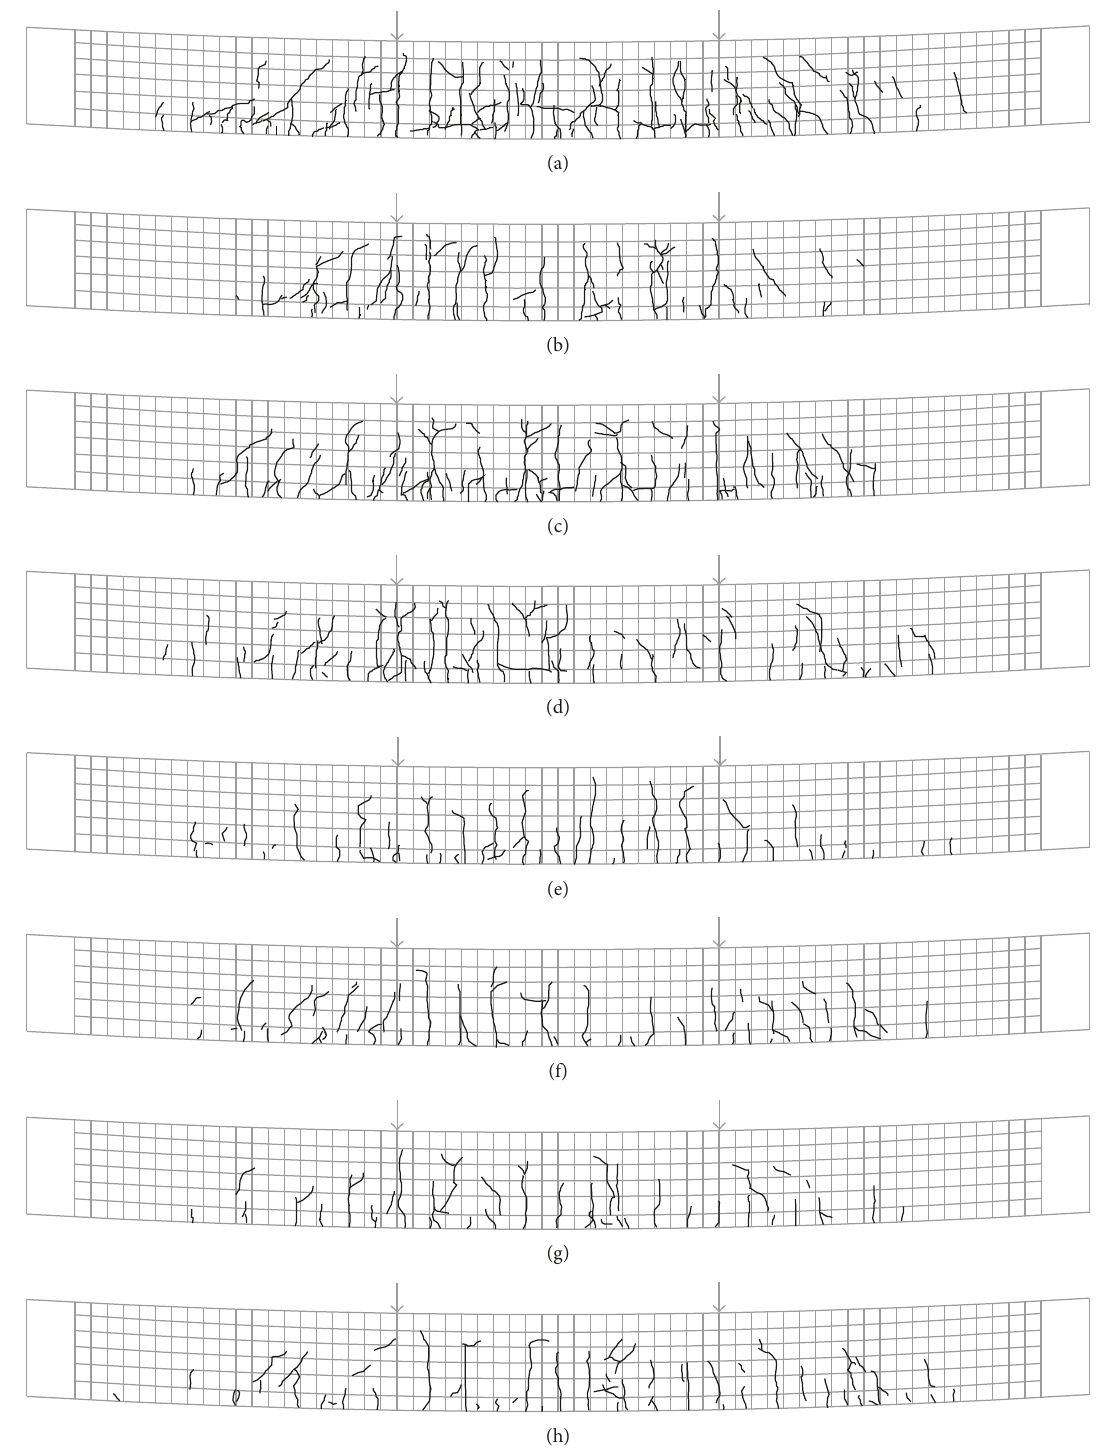
Figure 8: Crack patterns of beams at failure. (a) RCB-0, (b) RCB-33, (c) RCB-66, (d) RCB-100, (e) HRCB-0, (f) HRCB-33, (g) HRCB-66, and (h)